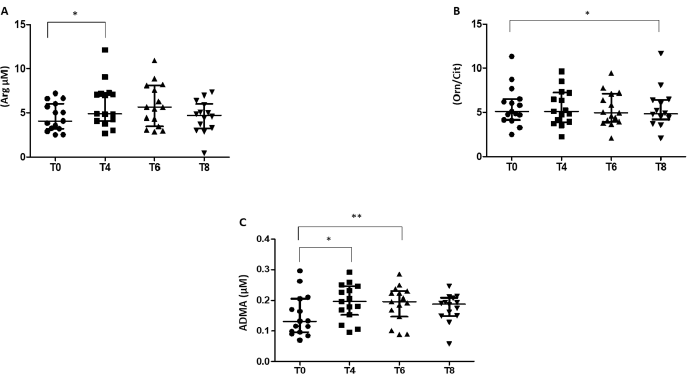
Figure 3. Levels of ( A ) arginine (Arg), ( B ) ratio ornithine and citrulline (Orn/Cit), and ( C ) asymmetric dimethylarginine (ADMA) at baseline (T0) and for 180 min following an oral glucose load in RBCs isolated from prediabetic patients. • T0; (cid:4) T4; (cid:78) T6; (cid:72) T8. Data are expressed as median and interquartile range. n = 18; * p < 0.05, ** p <